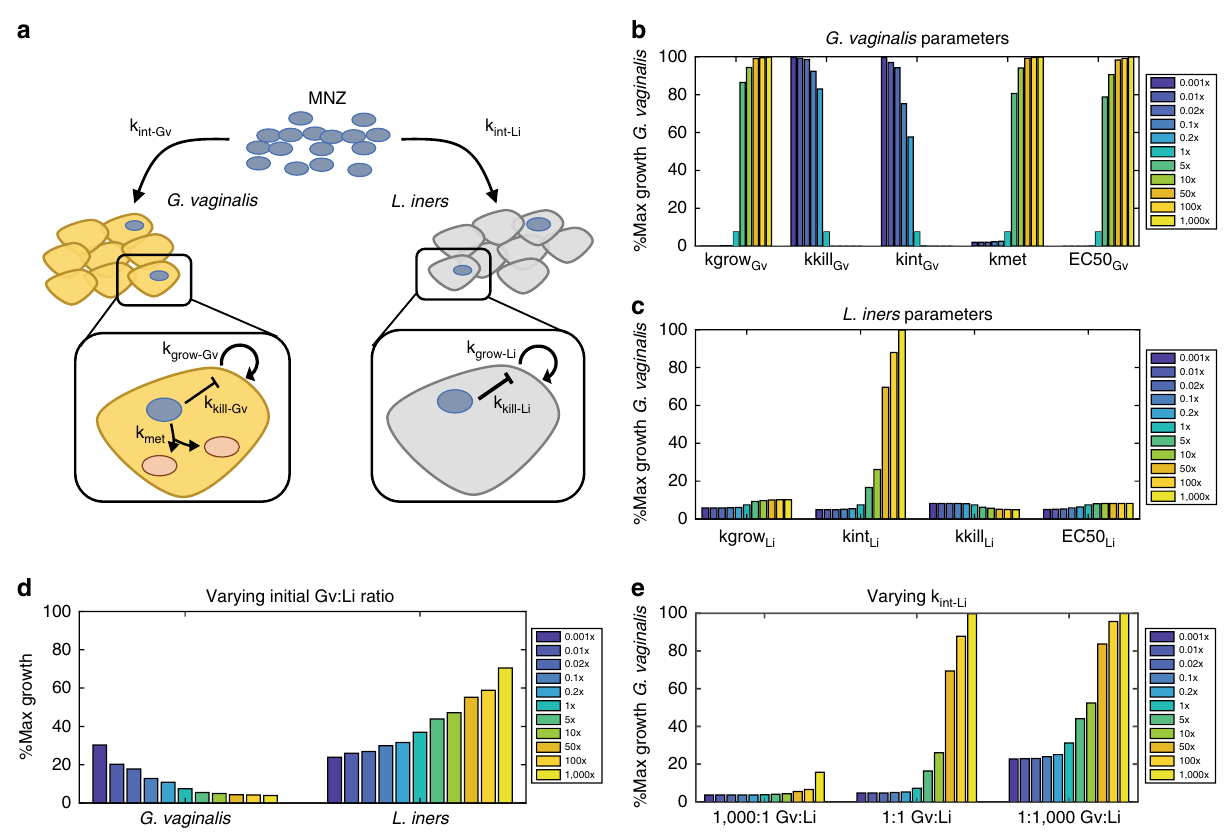
Fig. 1 Model schematic for bacterial growth dynamics in BV with MNZ treatment. a MNZ is internalized by both G. vaginalis ( Gv ) and L. iners ( Li ) at rates k int-GV and k int-LI , cells are proliferating at k grow-GV and k grow-LI and MNZ inhibits growth by k kill-GV and k kill-LI . For Gv , a potential mechanism of MNZ resistance is the bacterial-mediated interactions to the drug leading to the formation of metabolites ( k met ). b Sensitivity of Gv growth with 500 μ g/ml MNZ when parameters directly related to Gv growth are varied 0.001× to 1000× baseline values. Percent maximal growth refers to the fi nal cell count compared to the carrying capacity of the culture, or the maximum cell density the unperturbed culture can reach at 48 h based on initial cell density. c Sensitivity of Gv growth with 500 μ g/ml MNZ when parameters related to Li survival are varied 0.001× to 1000× baseline values. d Percent maximal growth of Gv (left) and Li (right) when the initial ratio of Gv to Li is varied with 500 μ g/ml MNZ treatment. e Percent maximal growth of Gv when MNZ internalization rate of Li is varied at three different population compositions with 500 μ g/ml MNZ